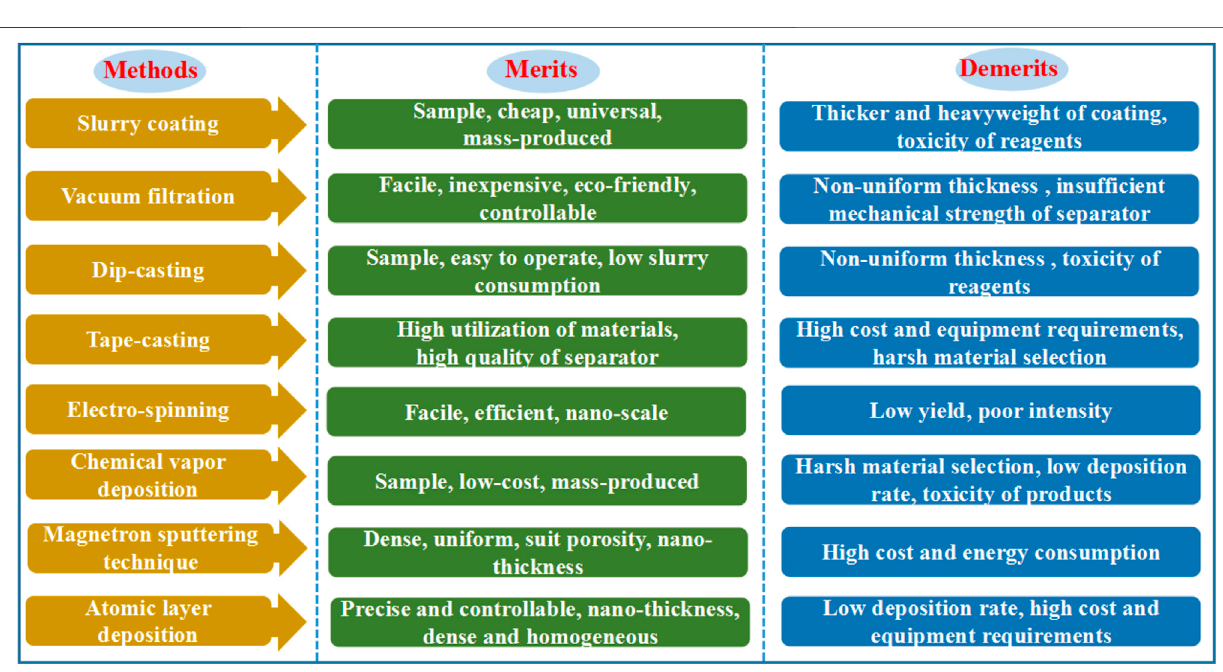
Frontiers in Energy Research |